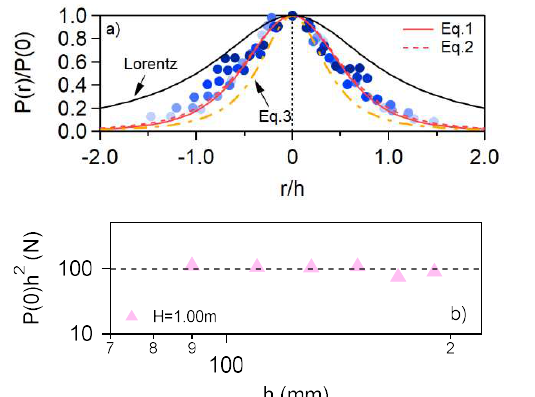
Fig. 4. Some results for 𝑯 =1m. a) Pressure curves scaled by 𝑷(𝟎) vs. 𝒓/𝒉 . The graph includes the Lorentz model (black line), the Westergaard solution (dashed-point line). Kelvin (red dashed line) and Boussinesq solution (red line), were obtained for 𝝂 =0.27. b) We observe the scaled curve 𝑷(𝟎)𝒉 𝟐 vs. 𝒉 . All data was obtained from [11].